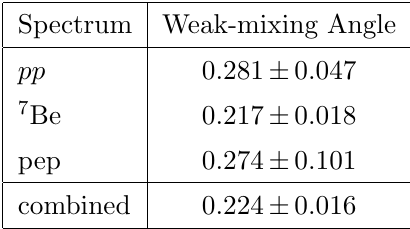
Table 1 . Shown are the sin 2 ( (cid:18) W ) (cid:12)ts to individual and combined Borexino low- energy solar neutrino rates. Uncertainties shown are averages of upper and lower values. The preference for a low value of sin 2 ( (cid:18) W ) results from the relatively small uncertainty in the 7 Be data. The text develops this